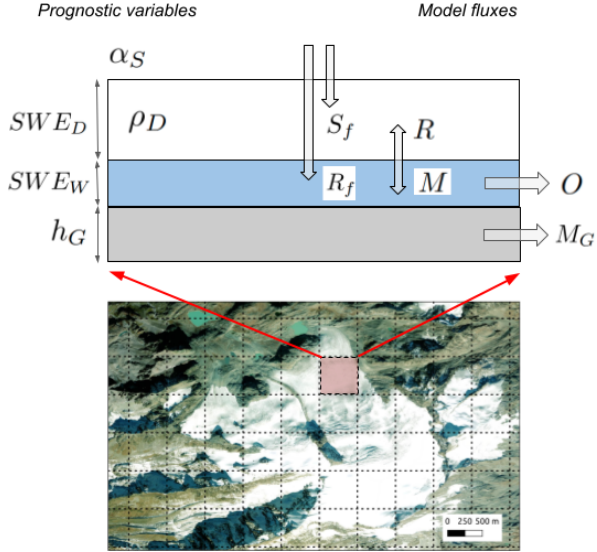
Figure 1. Prognostic variables and main mass fluxes of S3M (see Sect. 2 for details). α S is snow albedo (–), S f and R f are snow- fall and rainfall rate (mm (cid:49)t − 1 ), respectively, SWE D (mm) and ρ D (kgm − 3 ) are dry snow water equivalent and dry bulk snow density, respectively, SWE W is wet-snow water equivalent (mm), R , M , and O are snow refreezing, melt, and outflow, respectively (mm (cid:49)t − 1 ), h G is glacier thickness (m), and M G is ice melt (mm (cid:49)t − 1 ). Note that albedo is listed here as a prognostic variable for clarity, but the actual, underlying prognostic variable is technically snow age A s . The background image is the Rutor glacier in northwestern Italy (ESRI Satellite